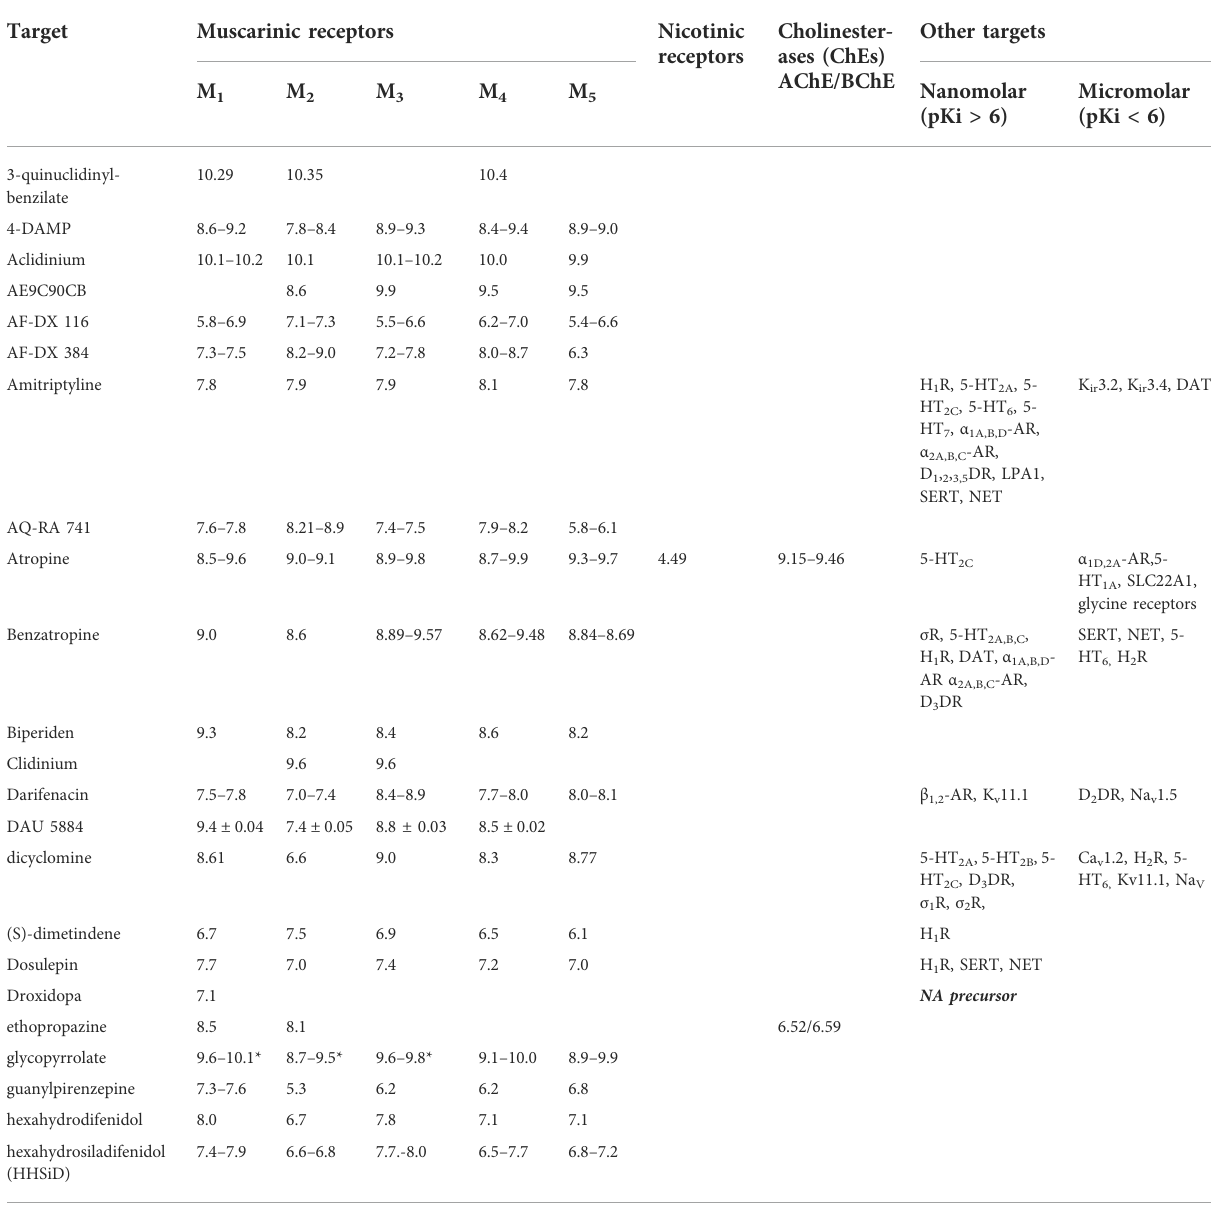
TABLE2Effectsoforthostericantagonistsonmuscarinicreceptorsandothertargets.Thecompoundsarelistedalphabetically.Thenumbersindicate pKi values. Please note that a higher pKi indicates higher af fi nity. Unavailable data are shown as blank spaces. The af fi nities of nicotinic receptors are not divided among speci fi c subunits. The af fi nities of other, noncholinergic targets are divided into nanomolar (pKi > 6) and micromolar (pKi <